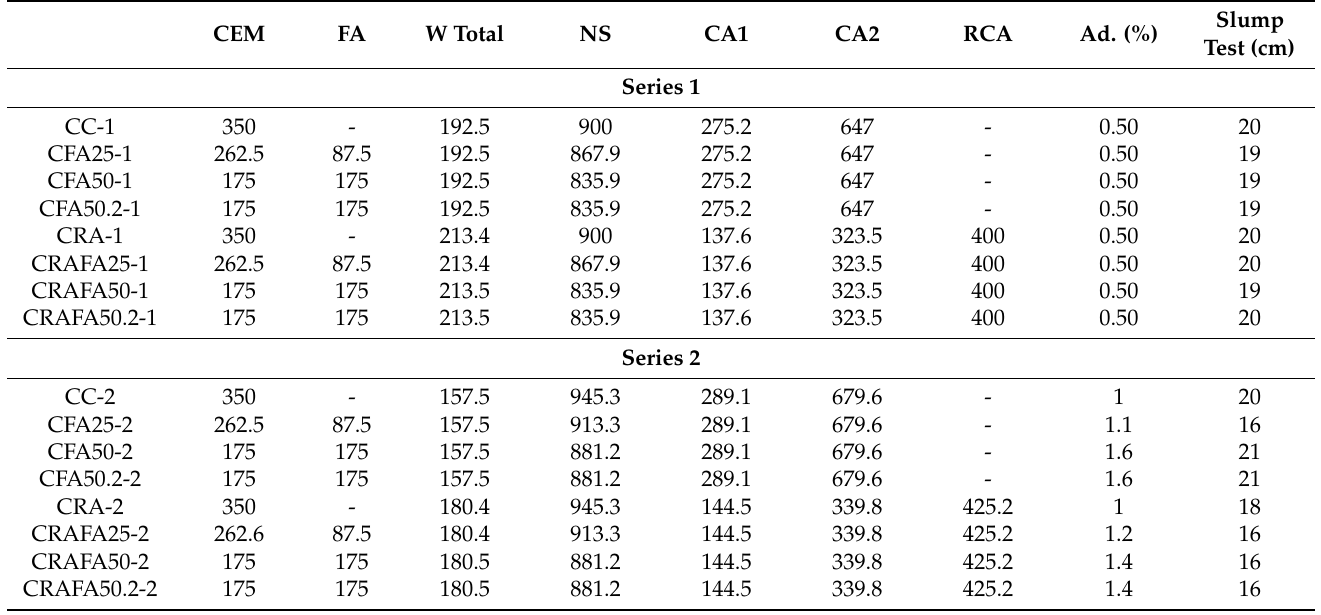
Table 2. Mixture proportions of Series 1 and Series 2 concretes. The values are given as weight over volume of concrete production (kg/m 3 ) (W: water, Ad: admixture). Ad. was used in % with respect to the cement’s weight